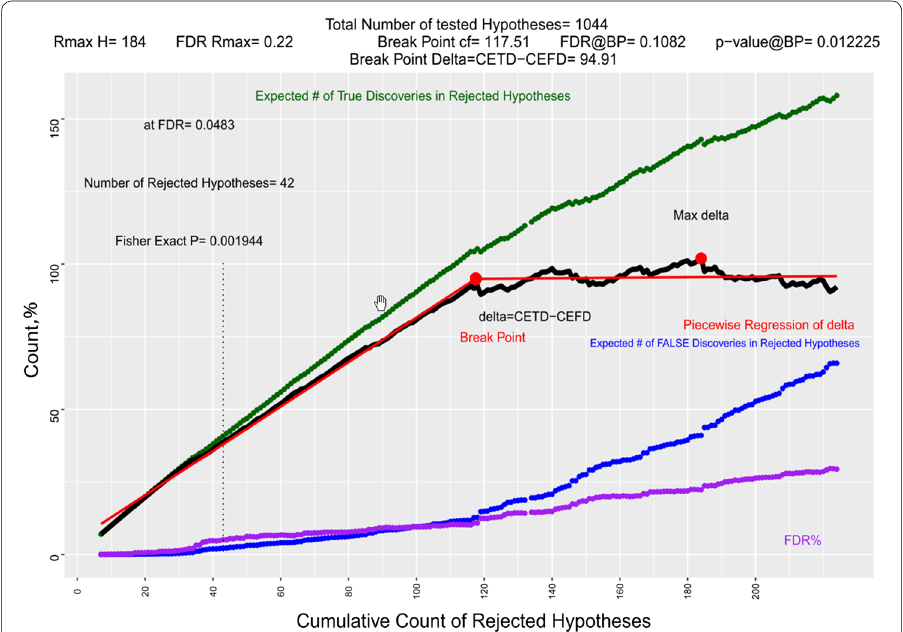
Fig. 4 Maximum δ and the breakpoint of piecewise regression with horizontal